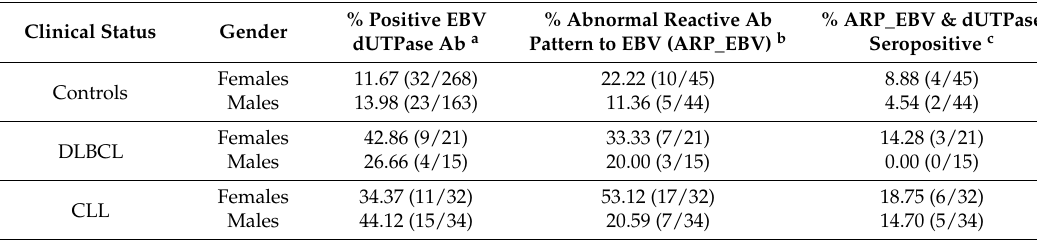
Table 3. Detection of anti-EBV-dUTPase antibodies (Ab) in patients with DLBCL or